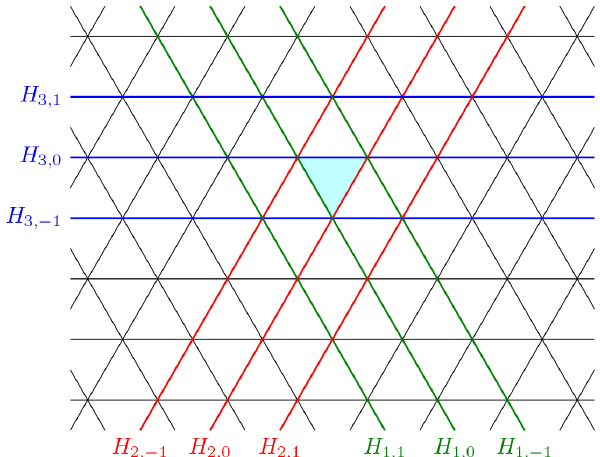
Figure 2. Illustration of the general idea of the cubulation method. The triangular grid is shown in terms of the triangle edges in black. Some parallel hyperplanes are shown in the same